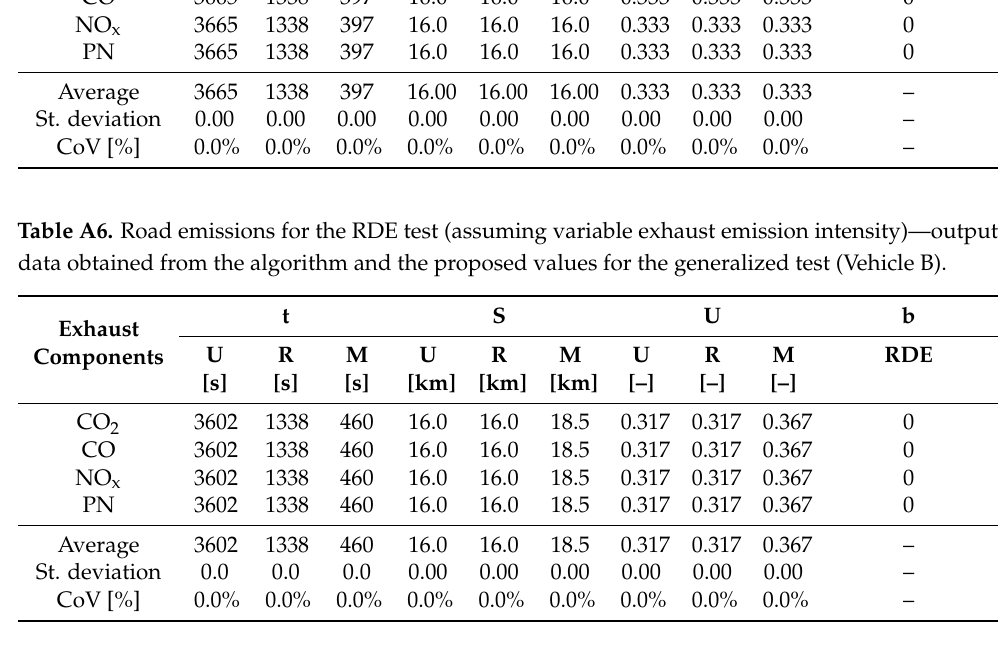
Table A7. Road emissions for the RDE test (assuming variable exhaust emission intensity)—output data obtained from the algorithm and the proposed values for the generalized test (Vehicle